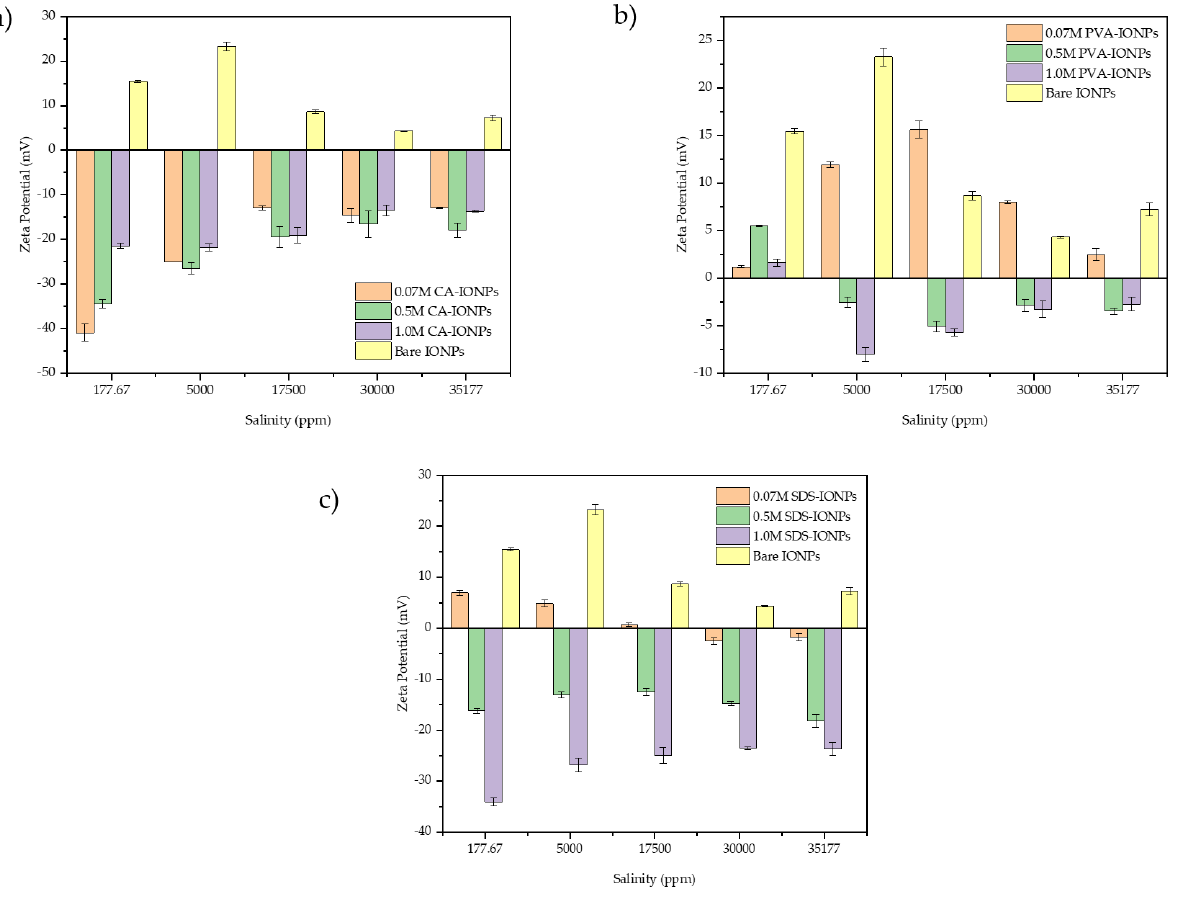
Figure 7. Zeta potential values of CA-IONPs, PVA-IONPs and SDS-IONPs under various molar ratios and salinities.